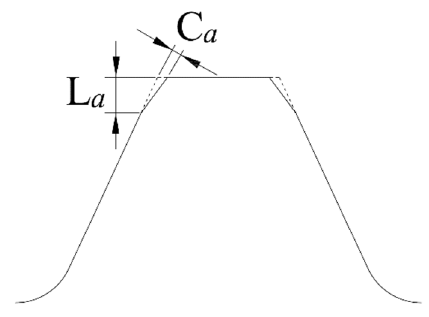
Figure 5. Illustration of parameters of linear tip relief modification. Table 2. DVs of optimization.